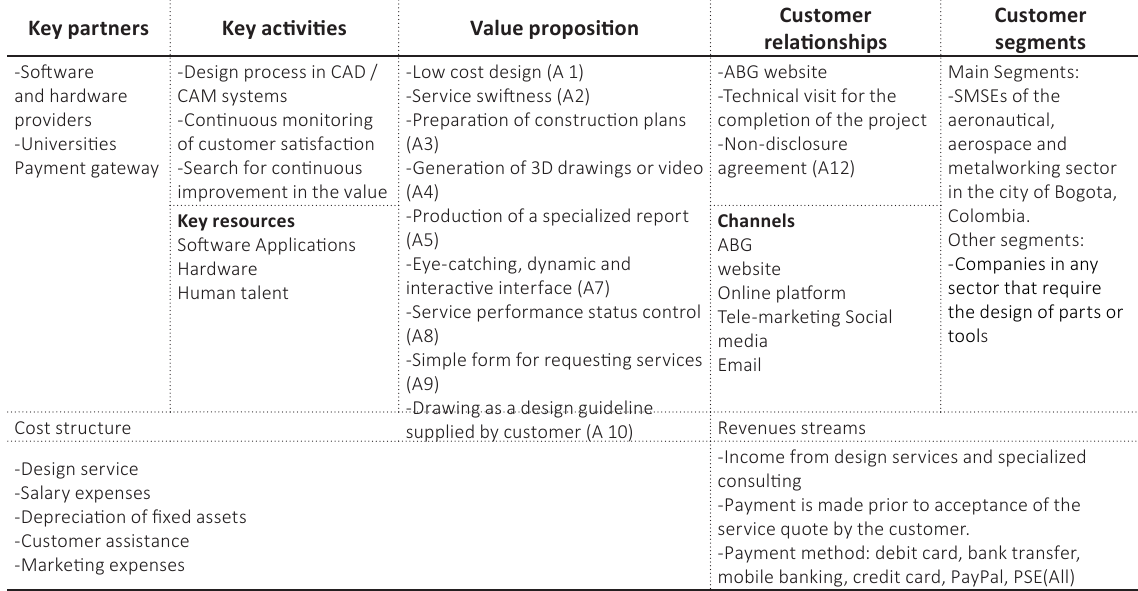
Table 4. Combination of Kano and CANVAS models